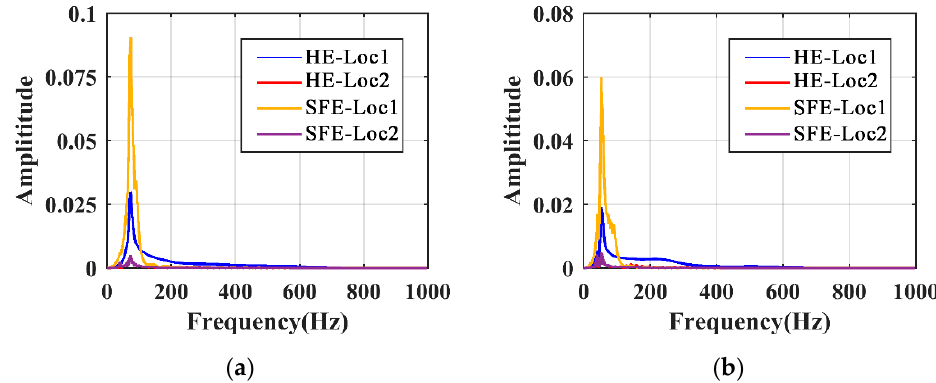
Figure 12. Time domain responses excited by different excitations: ( a ) beam 1; ( b ) beam 3.